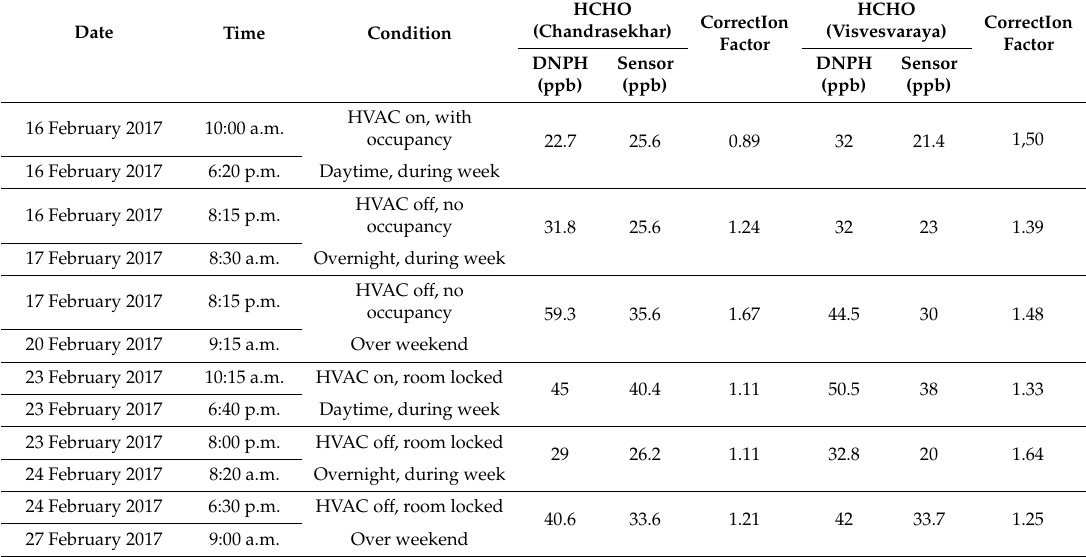
Table 3. Comparison of formaldehyde concentrations as indicated by Sensor C1 and reference DNPH passive sampling in Chandrasekhar and Visvesvaraya meeting